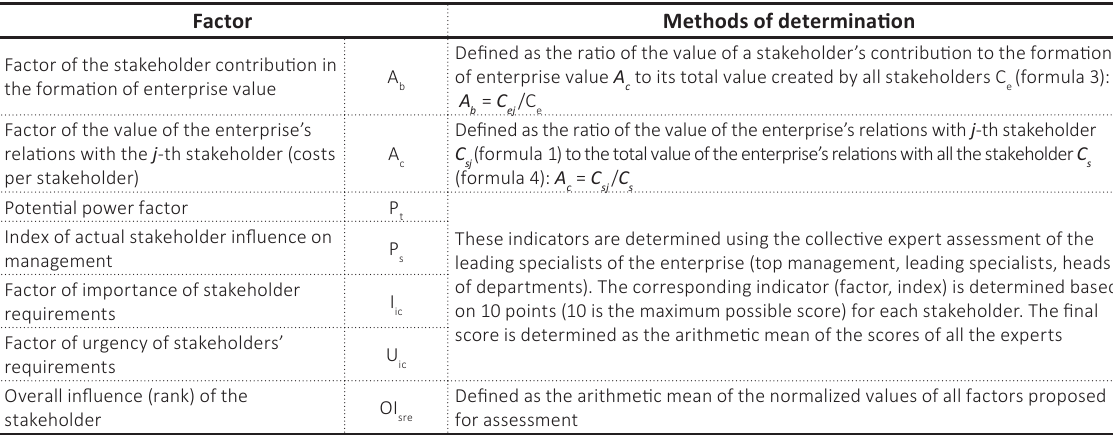
Source: Developed by the